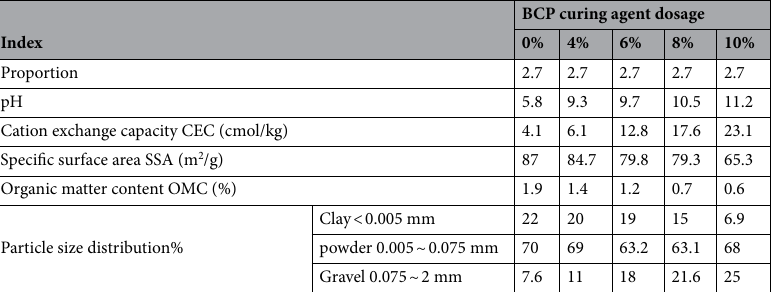
Table 5. Main parameters of the solidified soil with different BCP